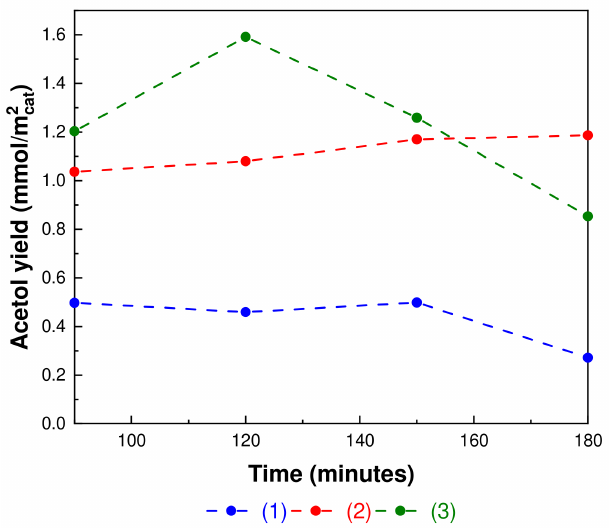
Figure 7. Yield of acetol after 90 min of reaction. ( 1 ) Cu NPs/ZrO 2 pH = 4, ( 2 ) Cu NPs/ZrO 2 pH = 7, ( 3 ) Cu NPs/ZrO 2 pH =